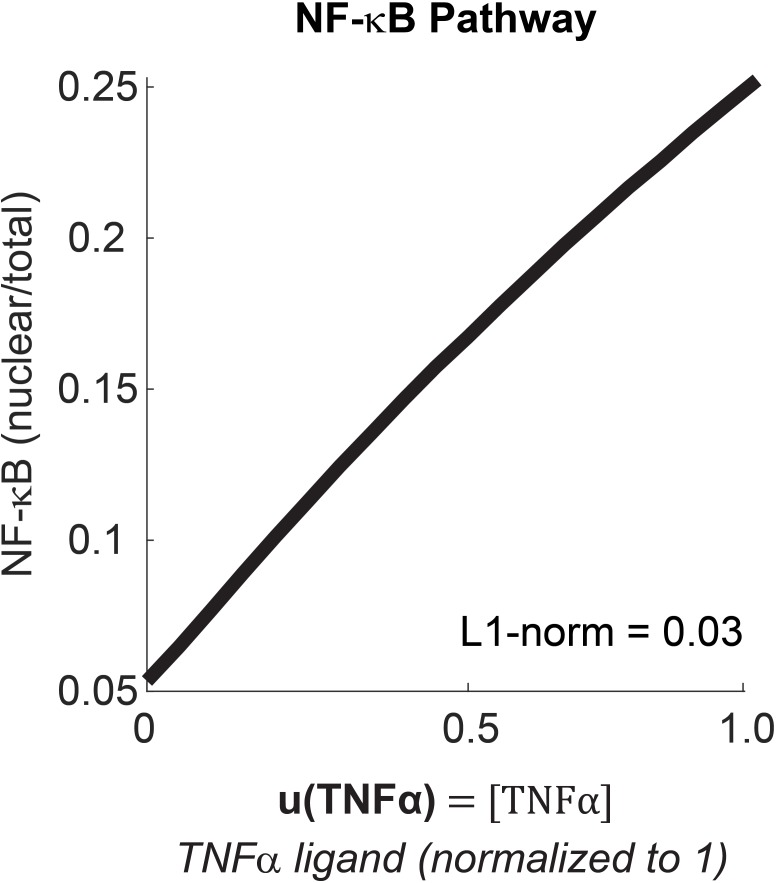
Numerical simulation of the input-output relationship of the NF-κB pathway.We used the model first built by Hoffman et al. in 2002 (Hoffmann et al., 2002) and later revised by Ashall et al. in 2009 (Ashall et al., 2009). The parameters in the model have been measured or fitted to single-cell dynamics in multiple cell types (Hoffmann et al., 2002; Ashall et al., 2009). We simulated the model here over a physiologically observed dynamic range, i.e., Lee et al. (2014) observed in HeLa cells that at saturating ligand dose (10 ng/mL TNFα, set to one in the model),~25% of NF-κB pool is nuclear. Linearity is assessed using the L1-norm, where L1-norm < 0.1 indicates linear relationship (see Materials and methods).